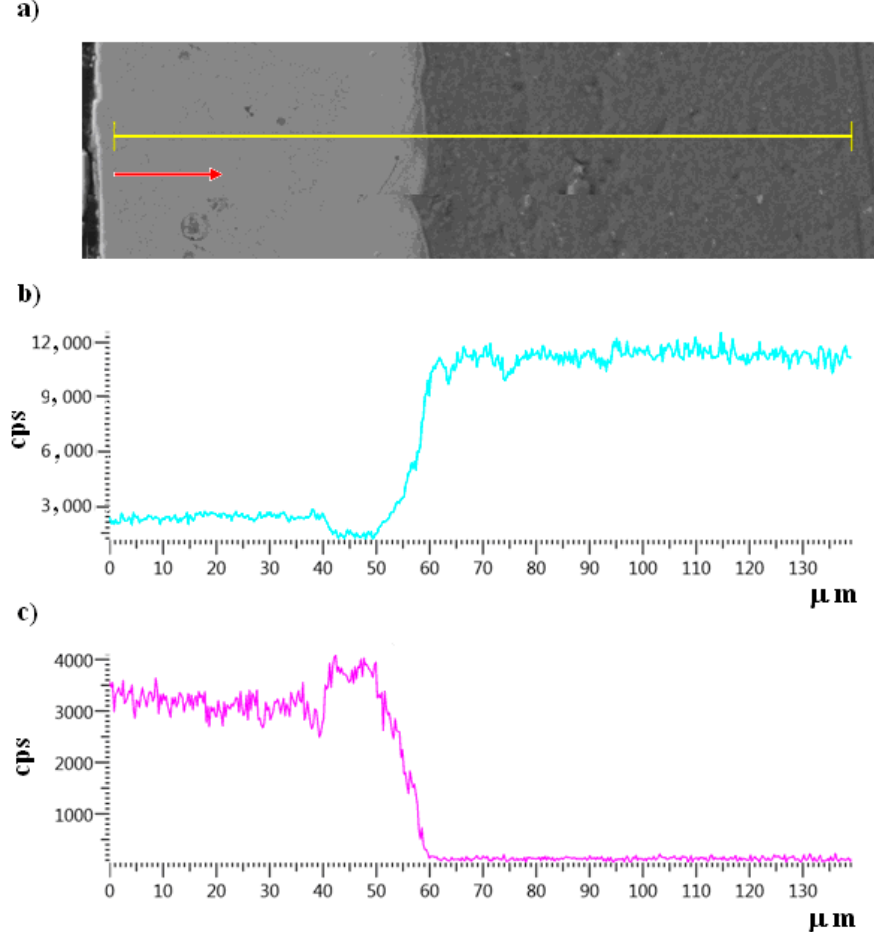
Figure 3. X-ray microanalysis of cross-section of Al/Cu alloy: ( a ) metallographic microstructure (with the line scanning) and content distribution: ( b ) aluminum and ( c ) copper.